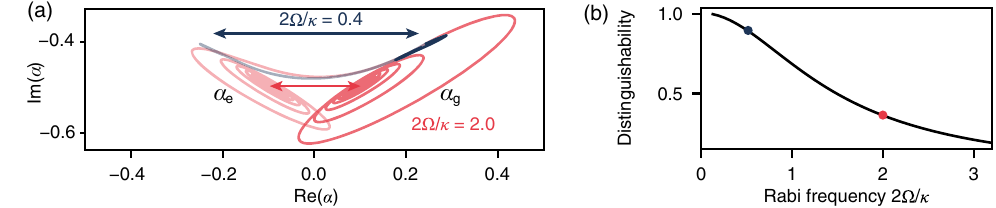
FIG. 10. (a) Q u T i P master equation simulation of a driven qubit dispersively coupled to the readout cavity, showing coherent state amplitudes versus time, conditioned on the qubit state. We show two pairs of α the expectation value α density matrix. (b) We use the relative distinguishability, defined as α cavity effects in the Bayesian filter method.